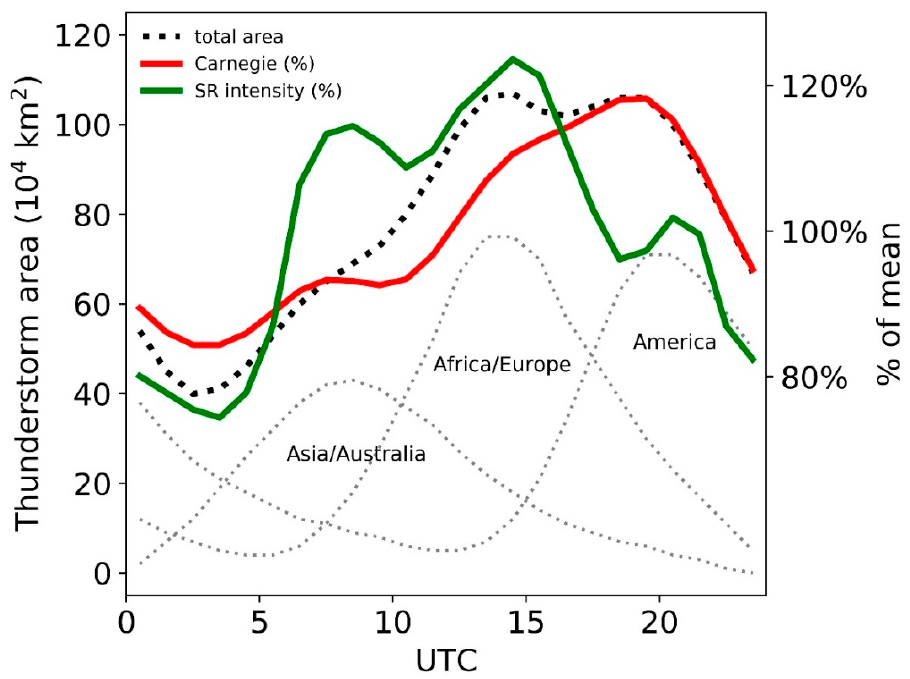
Figure 1. Comparison of the diurnal UT variations of thunderstorm surface area worldwide [16] and the UT variation of electric potential gradient over the ocean (Carnegie curve), calculated as percentage of the mean using annual values reported in Harrison [17]. The cumulative relative intensity of the first three SR modes of the E z field component ob- served at Nagycenk (NCK), Hungary, for the period 1994-1998, follows a similar general diurnal trend and exhibits three maxima which correspond to the three major sources of tropical thunderstorms. The peaks in the SR amplitude are better resolved in autumn and winter, when the influence from local thunderstorm activity at the observatory is lower [14].